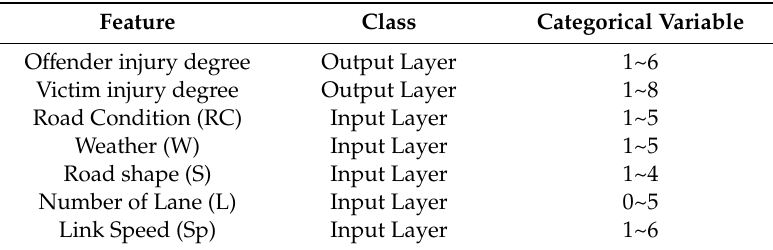
Table 3. Basic Data Variable Setting for